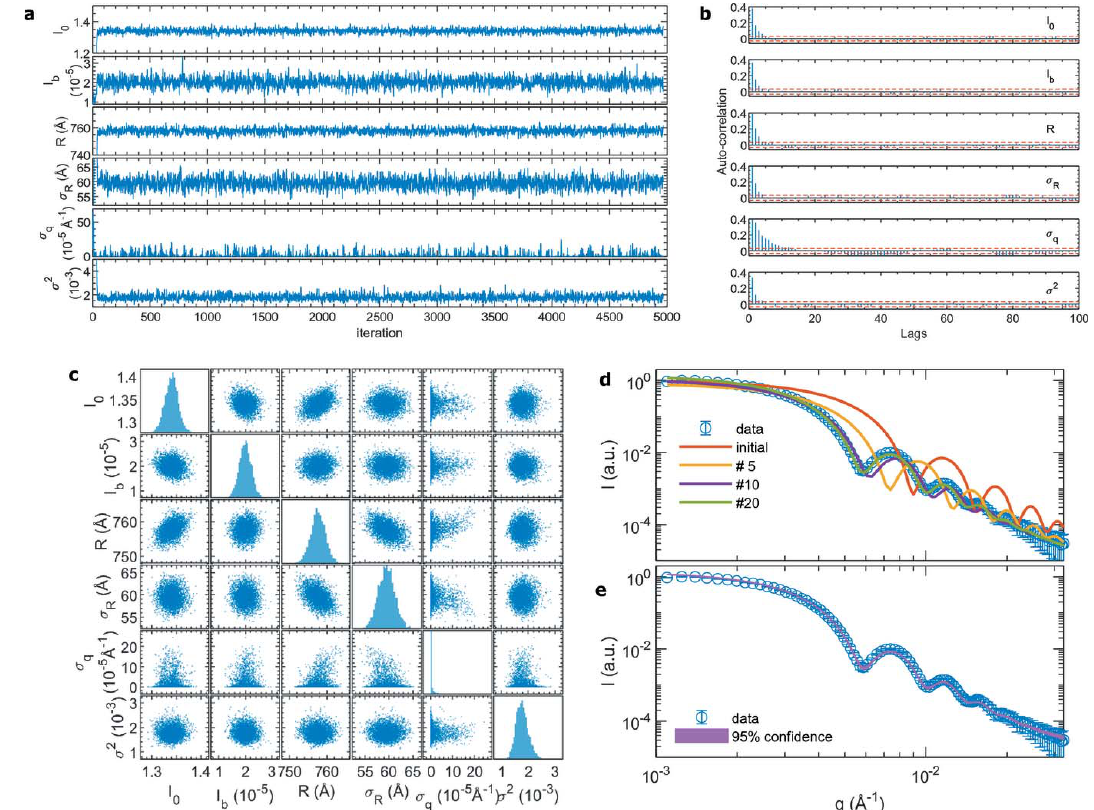
Figure 2 Result of SAXS data analyzed by Hamiltonian MCMC preconditioned with a non-trivial diagonal mass matrix as described in the text. ( a ) Trace of the parameters. The meaning of each parameter is defined in the main text. ( b ) Auto-correlation of the parameters sampled from post-burn-in iterations. The red dashed lines are 95% confidence bounds for the zero auto-correlation hypothesis. ( c ) Probability distributions of the parameters. The off-diagonal panels are joint distributions, and the histograms along the diagonal are marginal distributions. ( d ) Calculated SAXS with parameters from the initial guess, and the 5th, 10th, and 20th HMCMC iterations. ( e ) 95% confidence interval (between the 2.5% and 97.5%